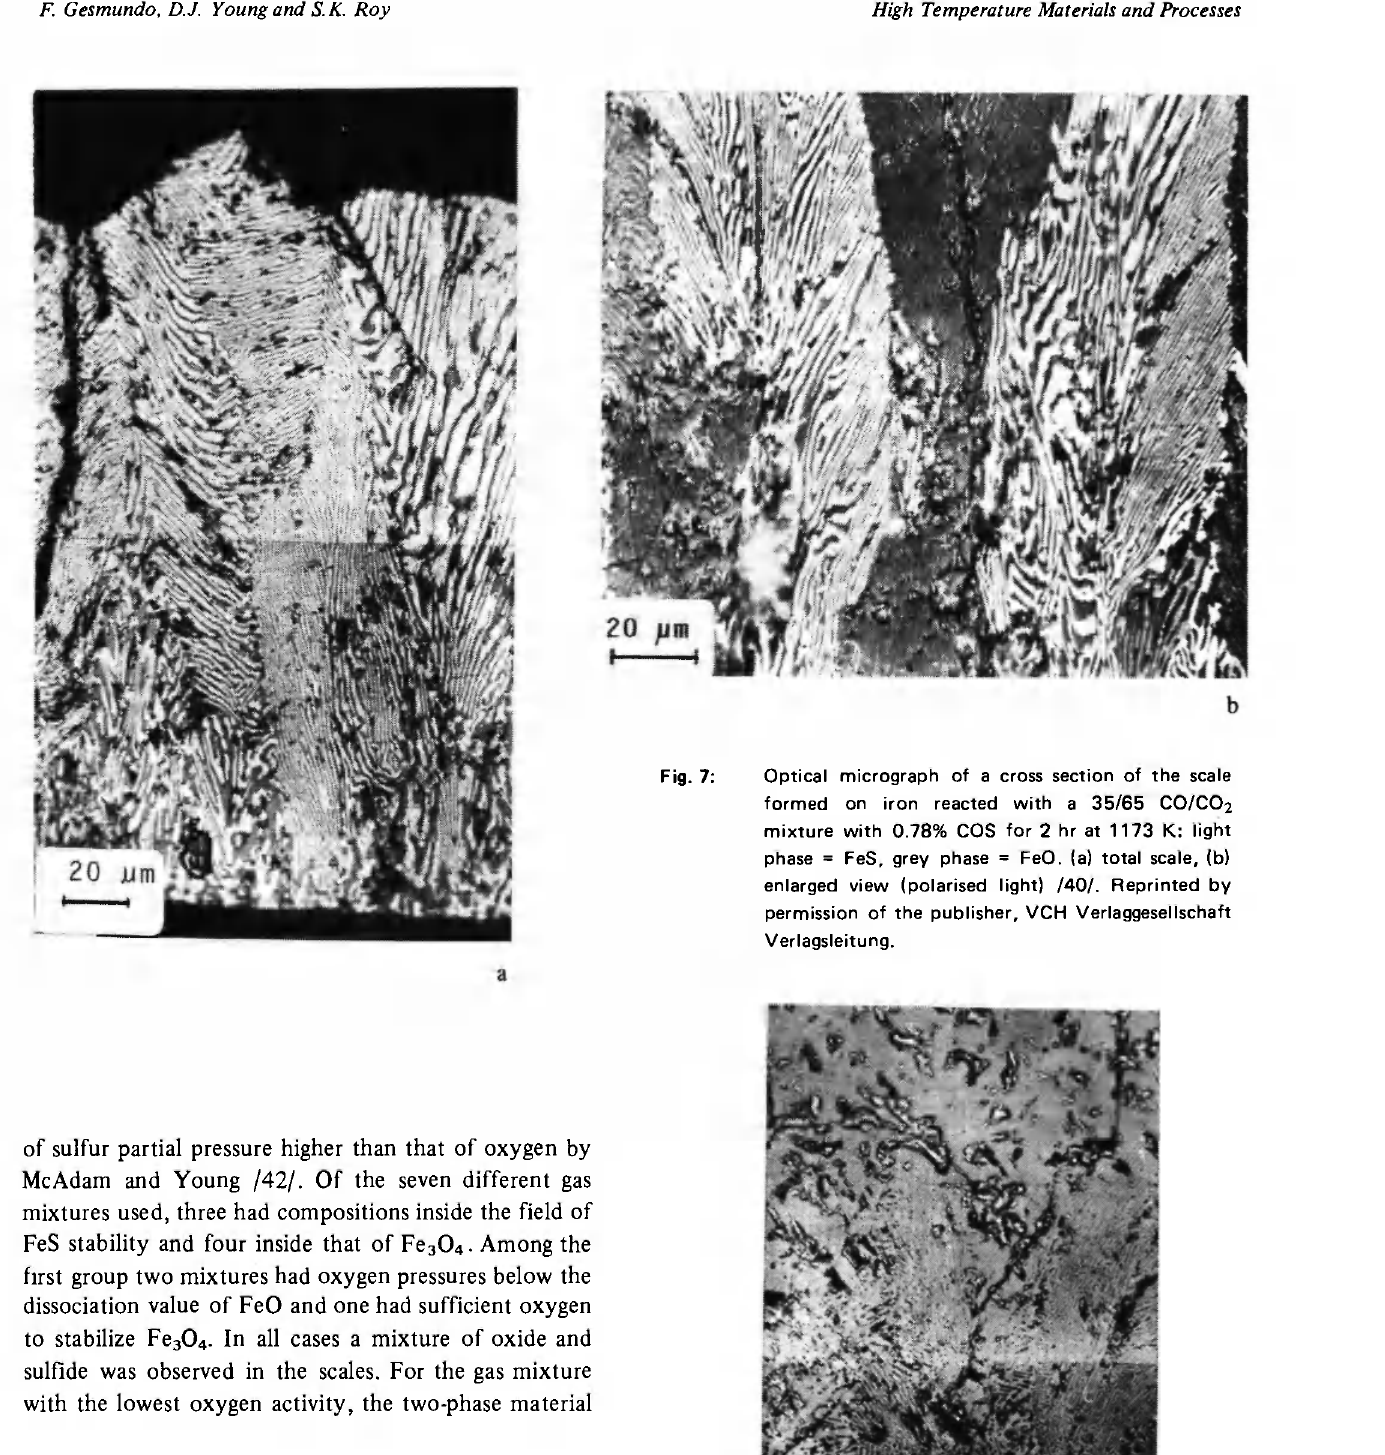
of sulfur partial pressure higher than that of oxygen by McAdam and Young /42/. Of the seven different gas mixtures used, three had compositions inside the field of FeS stability and four inside that of Fe 3 0 4 . Among the first group two mixtures had oxygen pressures below the dissociation value of FeO and one had sufficient oxygen to stabilize Fe 3 0 4 . In all cases a mixture of oxide and sulfide was observed in the scales. For the gas mixture with the lowest oxygen activity, the two-phase material